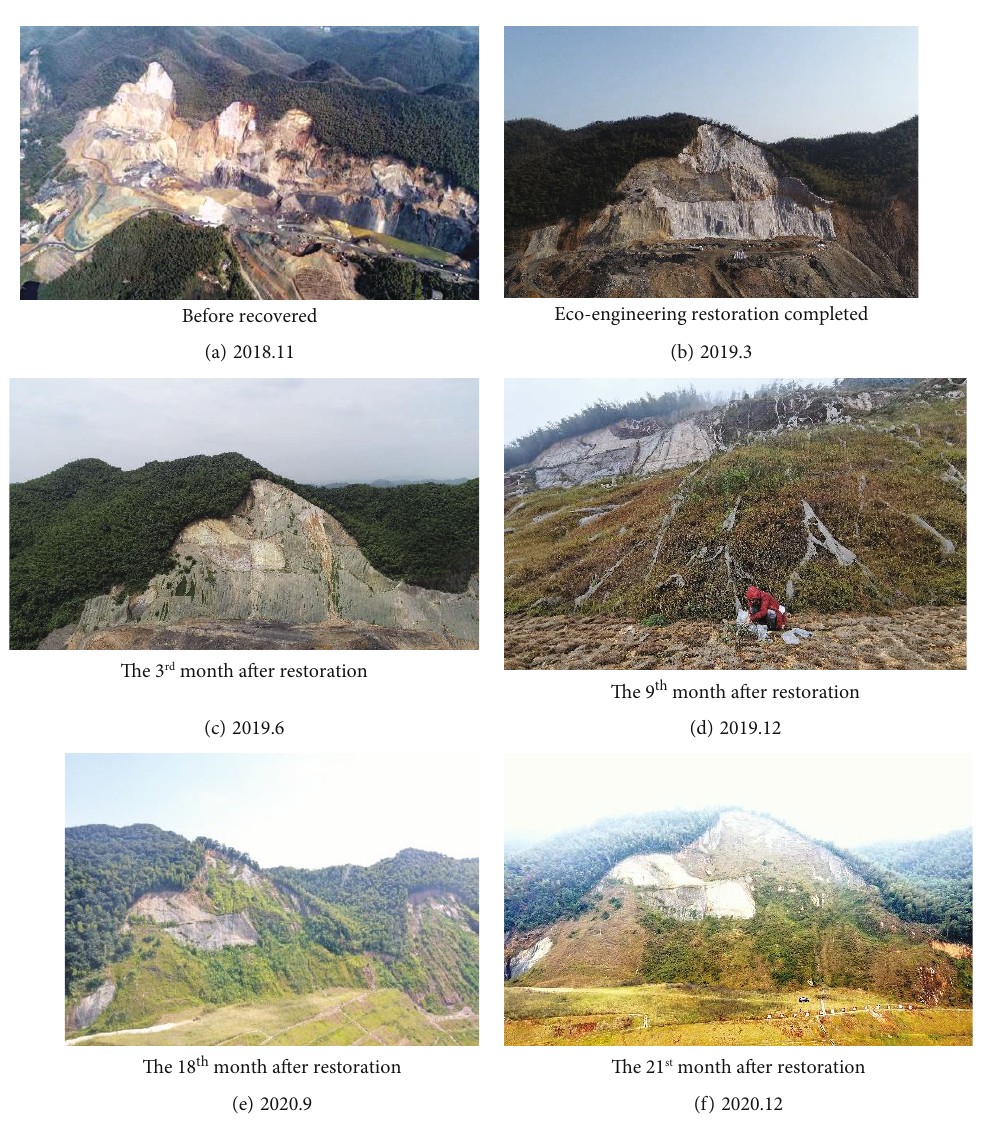
Figure 1: The time-dependent ecological restoration process of stone mine